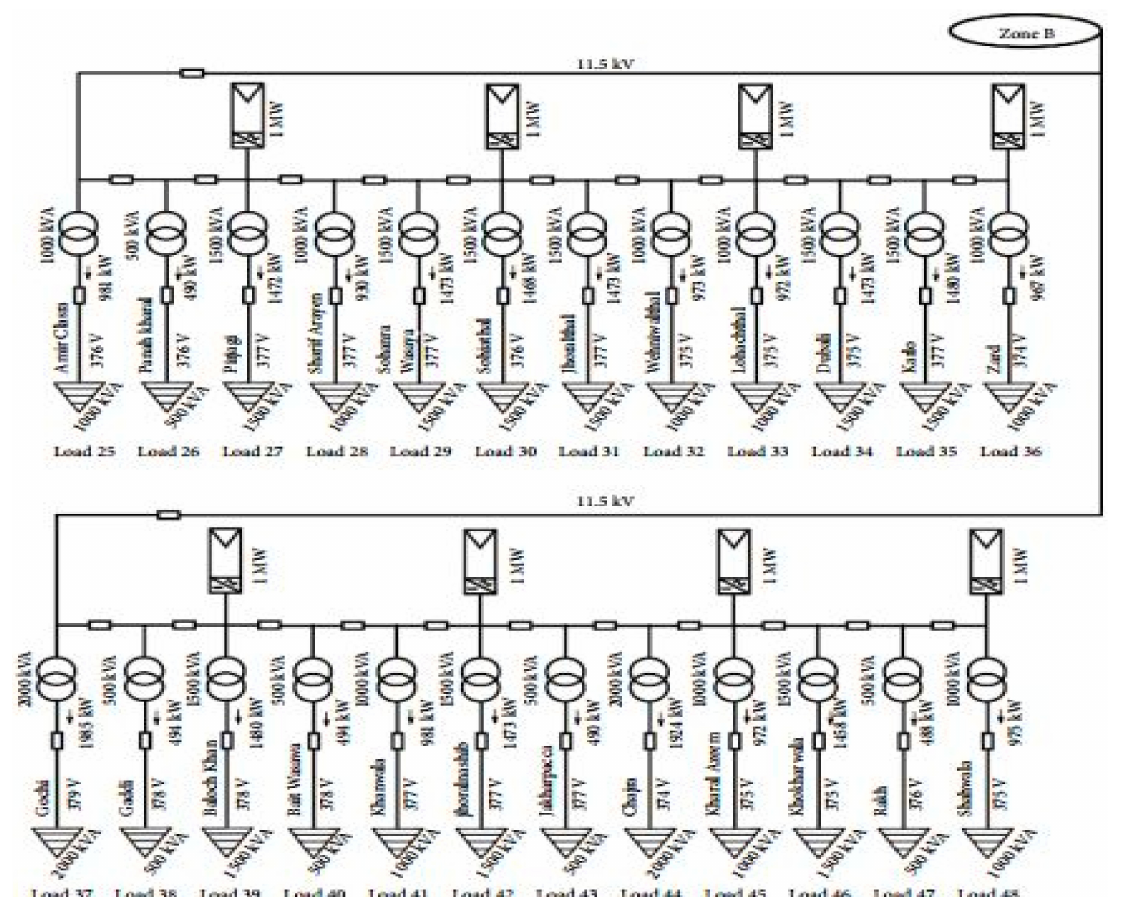
Figure 13. Grid with injected PV System and replaced transformers and lines having no overloads